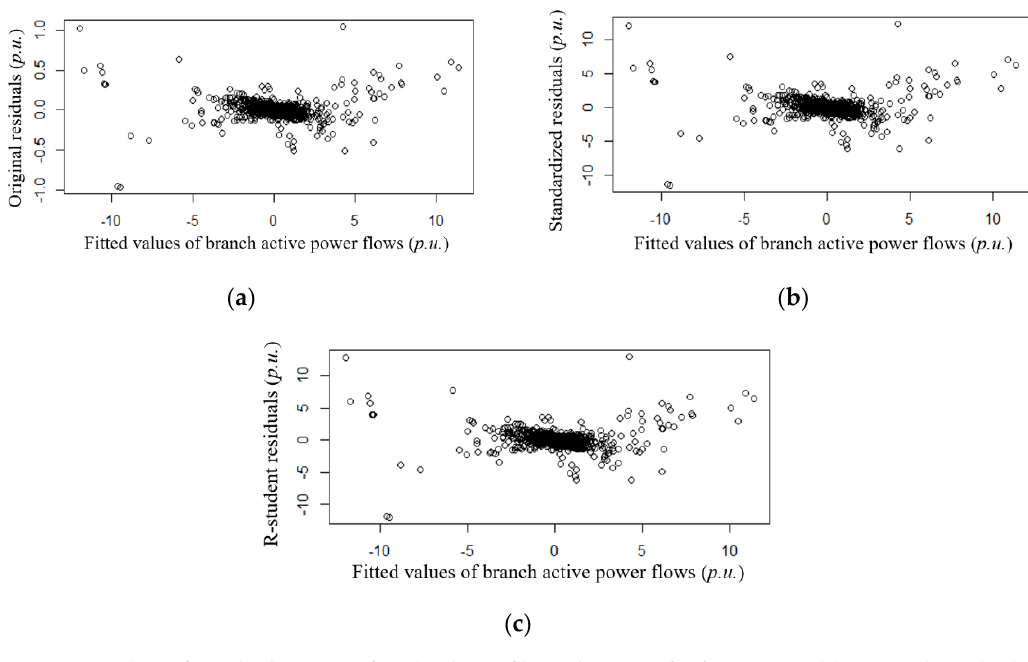
Figure 2. Plots of residuals against fitted values of branch power for hour 1 case : ( a ) Original residual e versus fitted value; ( b ) Standardized residual d versus fitted value; ( c ) R-student residual t versus fitted value. Table 1. Results with DDC and DC Models for Hour 1 Case.